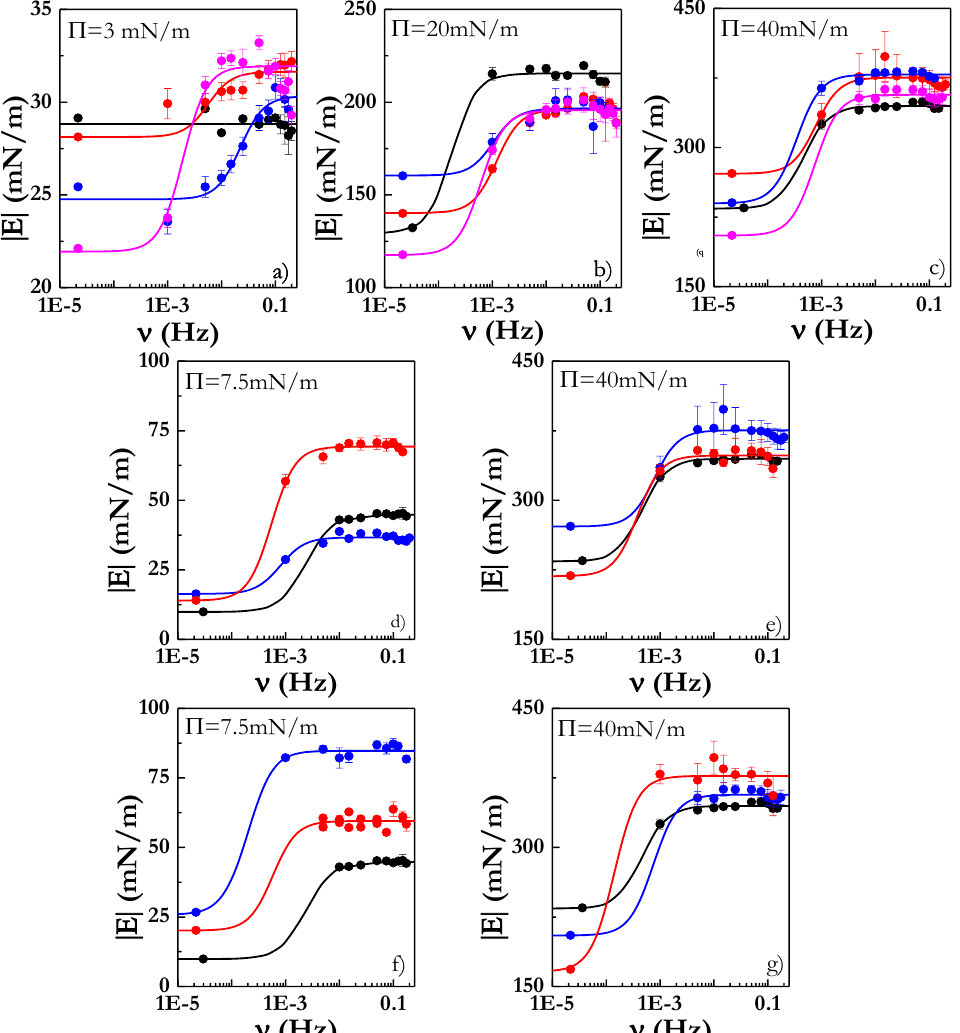
Figure 8. Experimental (symbols) and calculated using Equation (8) (lines) dependences of the interfacial dilational viscoelasticity modulus on frequency. ( a – c ) dependences of | E | on ν for DPPC after the incorporation of different x p values at fixed surface pressure values (data for CB): ( ● , ― ) 0, ( ● , ― ) 0.10, (●, ―) 0.33 and (●, ―) 0.75. ( d , e ) dependences of | E | on ν for DPPC after the incorporation of particles with different chemical nature at fixed surface pressure values and x p = 0.10: ( ● , ― ) pure DPPC, ( ● , ― ) DPPC upon incorporation of SiO 2 particles and (●, ―) DPPC upon incorporation of CB particles. ( g , f ) Dependences of | E | on ν for DPPC after the incorporation of particles with different chemical nature at fixed surface pressure values and x p =0.75: ( ● , ― ) pure DPPC, ( ● , ― ) DPPC upon incorporation of SiO 2 particles and (●, ―) DPPC upon incorporation of CB particles. (Note that the value of the | E | for the lowest frequency value was assumed as the quasi-static dilational elasticity obtained from the isotherm, with the value of the frequency being the compression ratio which for the here experiments is about 10 −5 Hz).